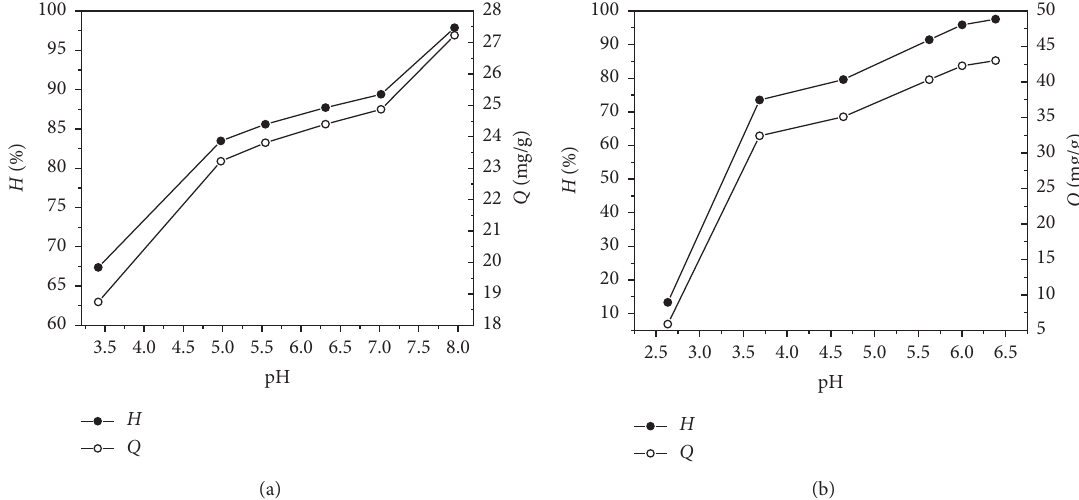
Figure 9: Effect of pH solution on the adsorption capacity and efficiency of Cd 2+ ((a) 30mins, 0.05g modified apatite) and Cu 2+ ((b) 45mins, 0.03g modified apatite) ( C o � 30 mg/L).